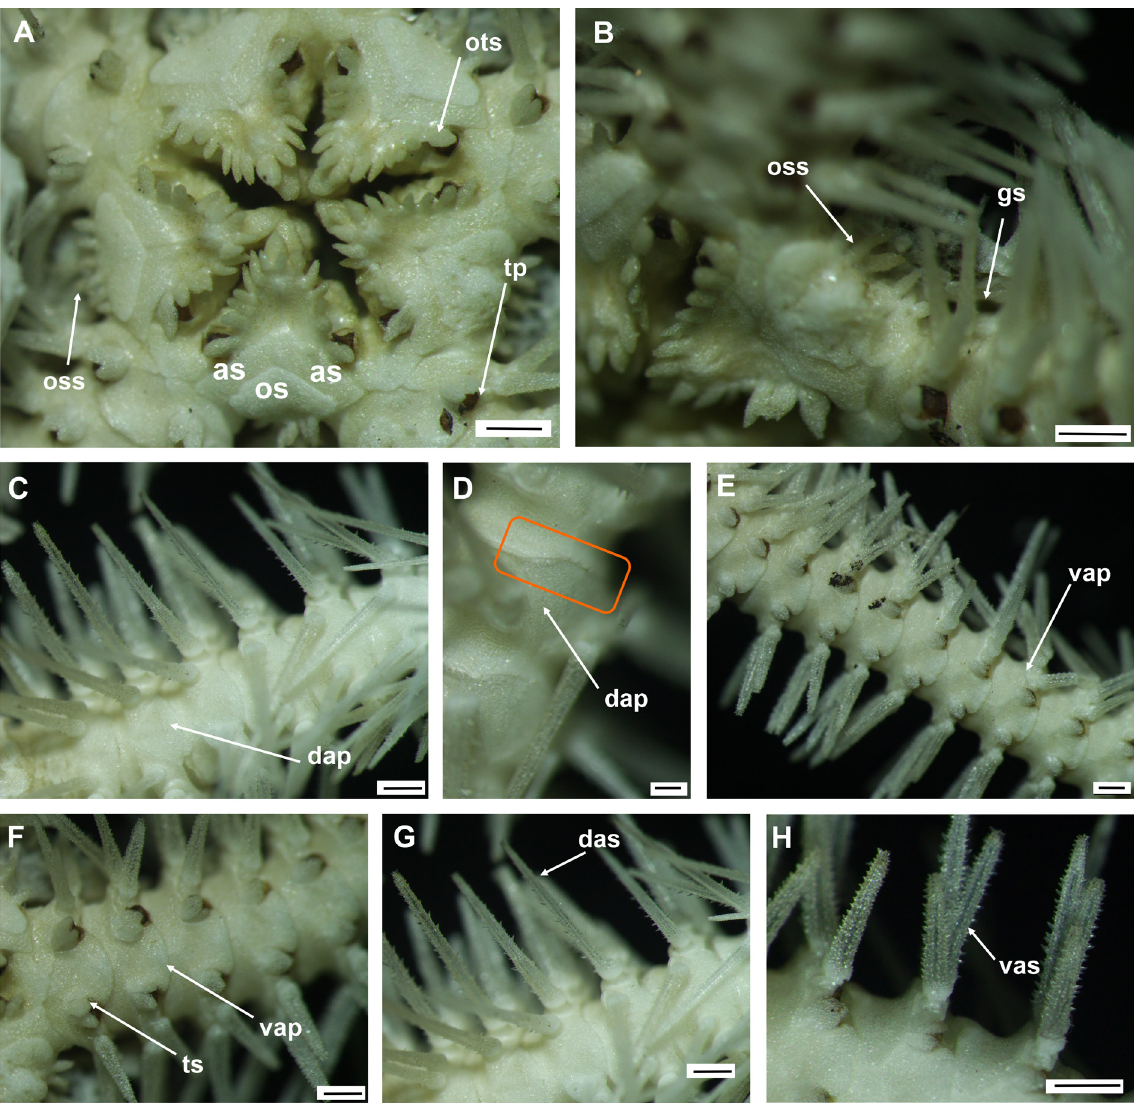
Fig. 18. Ophiopristis shenhaiyongshii sp. nov., holotype (IDSSE EEB-SW0022). A . Oral frame. B . Lateral disc. C–D . Dorsal arm (distal margin with minute spines highlighted on D). E–F . Ventral arm. G . Dorsal arm spines. H . Ventral arm spines. Abbreviations: as = adoral shield; dap = dorsal arm plate; das = dorsal arm spine; gs = genital slit; os = oral shield; oss = oral shield spine; ots = oral tentacle scale; tp = tentacle pore; ts = tentacle scale; vap = ventral arm plate; vas = ventral arm spine. Scale bars: A–C = 1 mm; D, G–H = 200 µm; E–F = 500